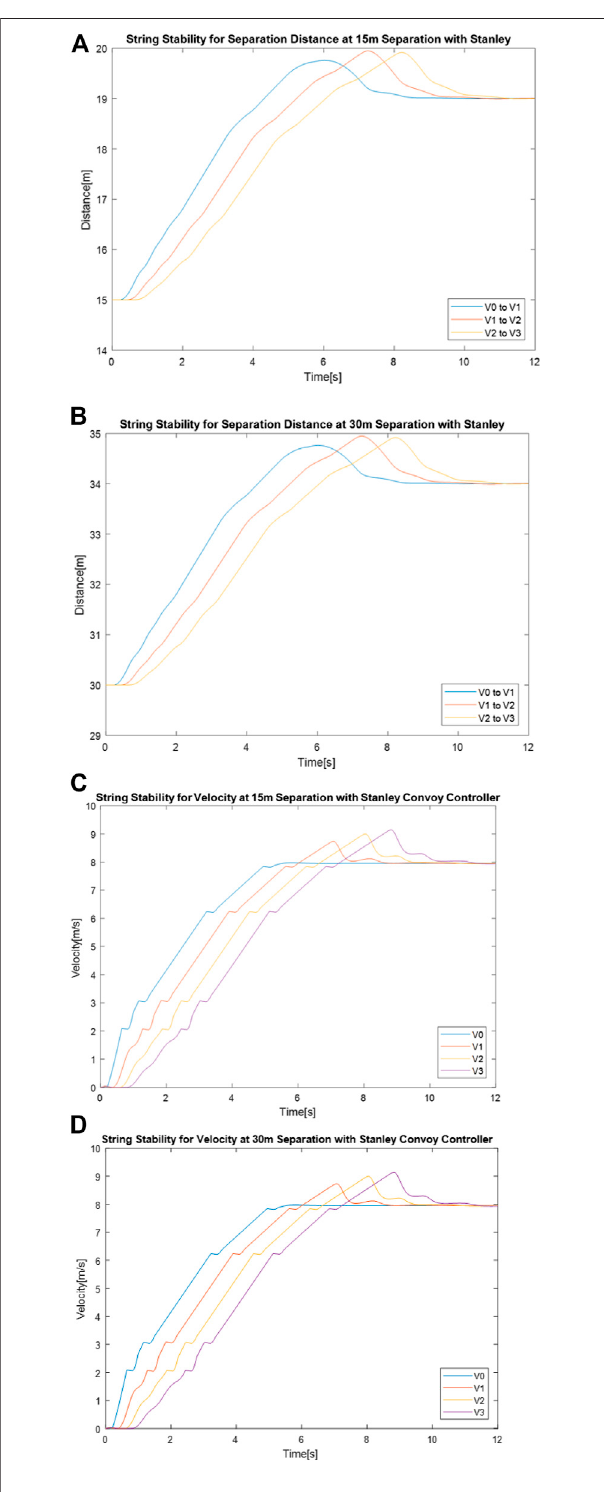
FIGURE 7 | Stanley convoy controller performance for separation distance between vehicles with a gap distance of (A) 15 m and (B) 30 m and velocity of vehicles over time with a gap distance of (C) 15 m and (D) 30 m.